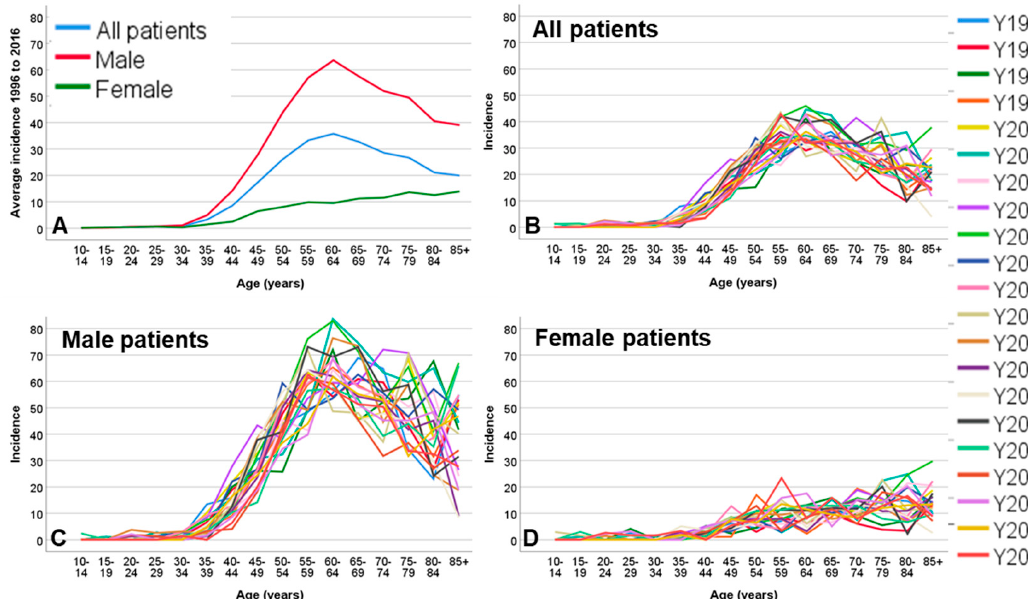
Figure 2. Incidence rates of head and neck cancer per 100,000 population in Thuringia per age group. ( A ) Average incidence rates from 1996 to 2016 for all patients, male and female patients. ( B – D ) Incidence rates for each year and age group for all patients ( B ), male patients ( C ), and female patients ( D ).